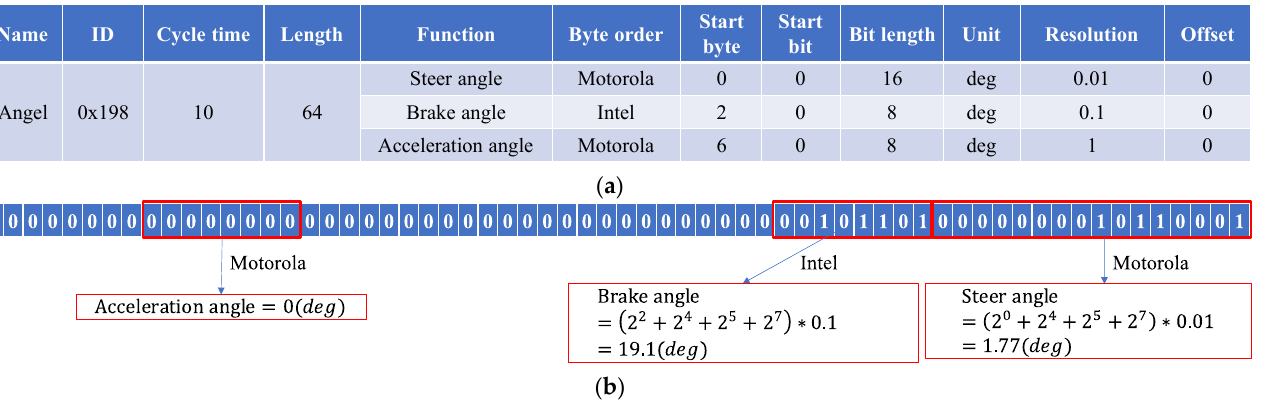
Figure 2. Correspondence diagram between DBC file and CAN messages: ( a ) 0x198 Message definition in DBC; ( b ) Message data decoded according to DBC .